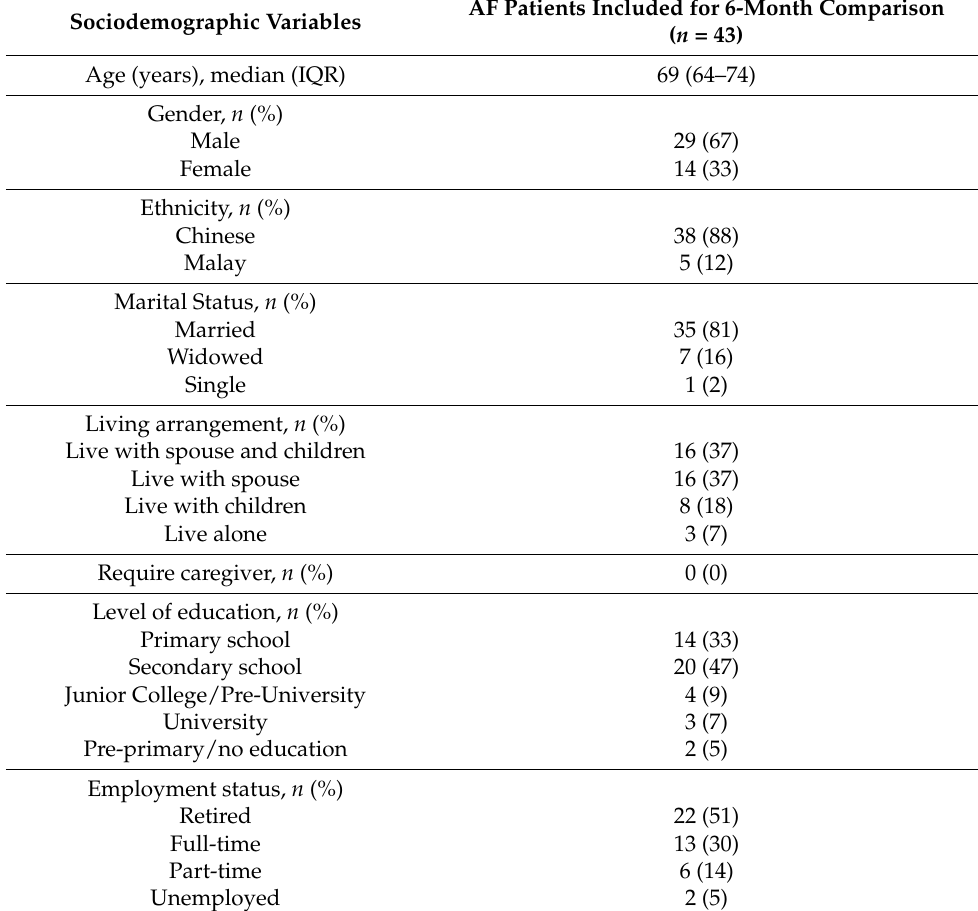
Table 2. Participant sociodemographic characteristics. AF Patients Included for 6-Month Sociodemographic Variables